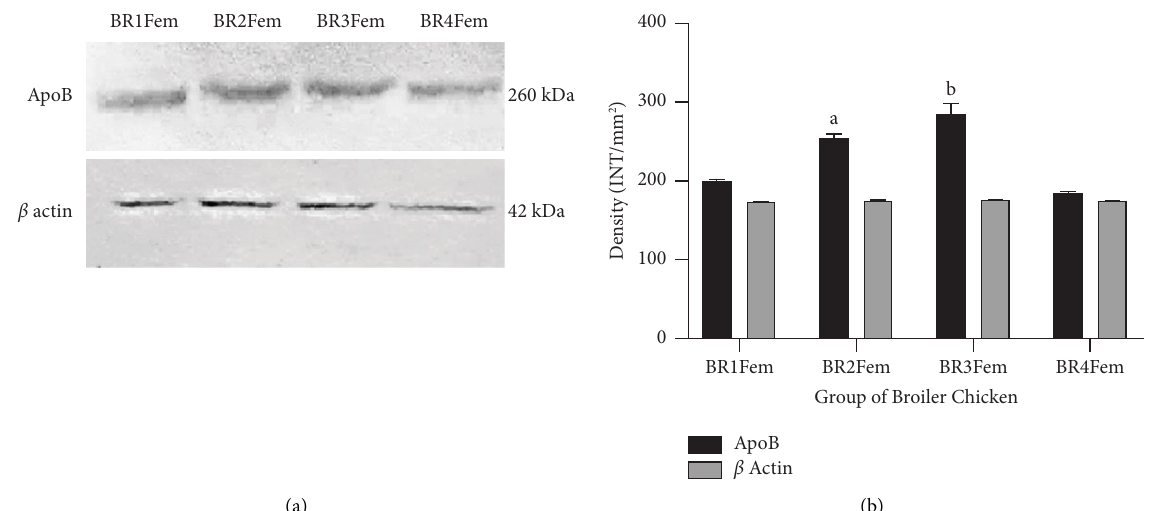
Figure 2: Te level of ApoB protein of broiler chicken femur from four locations. (a) Te expression profle of ApoB protein of broiler chicken isolated from 4 diferent locations. (b) Te density of ApoB protein levels analysed by quantity one software. β actin was used as the loading control. p < 0 . 05, Tukey’s HSD